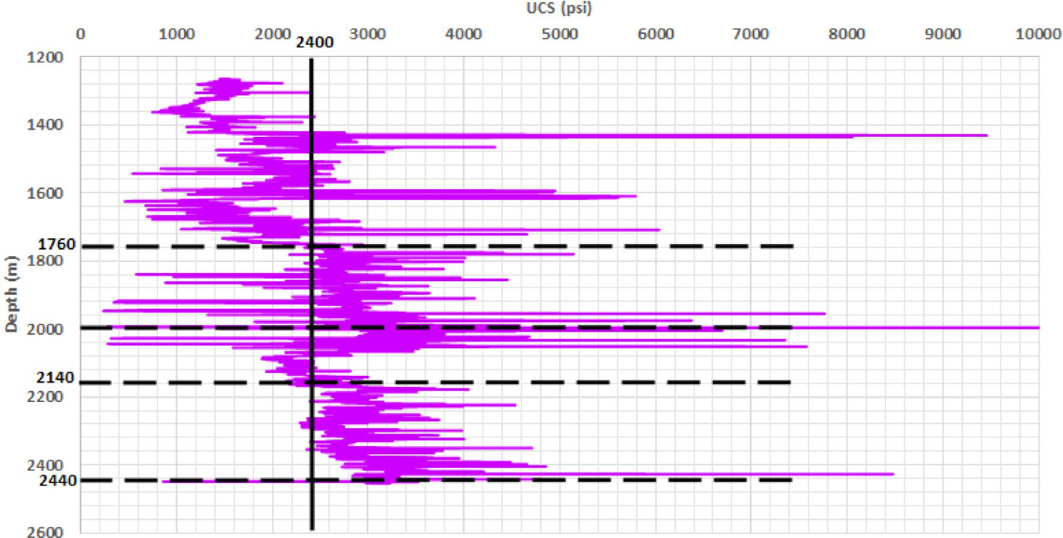
Fig. 23 UCS of Field